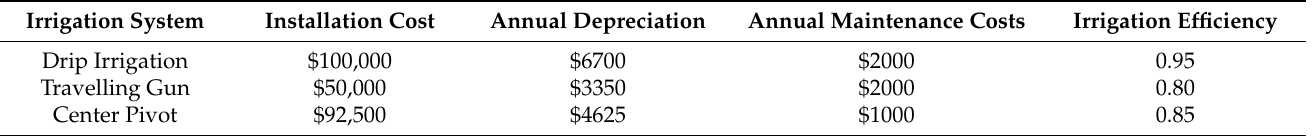
Table A3. The market prices used in this study. These values represent the average seasonal price received by Maryland farmers in 2003, as reported by the Maryland Agricultural Statistics Services (MASS). This table also includes the percentage of total agricultural cropland in Maryland dedicated to the production of each crop commodity in 2003.